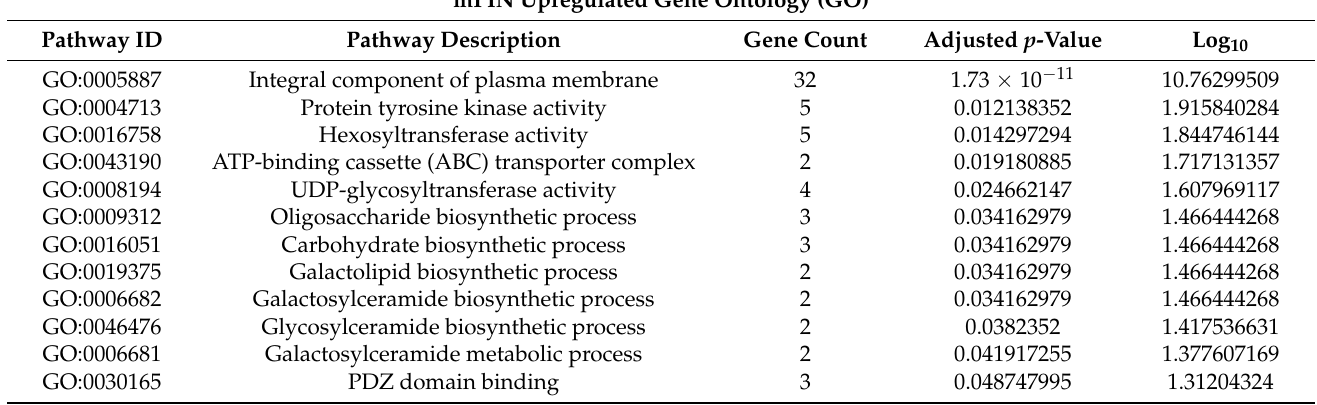
Table 1. A gene ontology (GO) enrichment analysis of membrane proteins upregulated in mPIN, MT, and AT of prostate